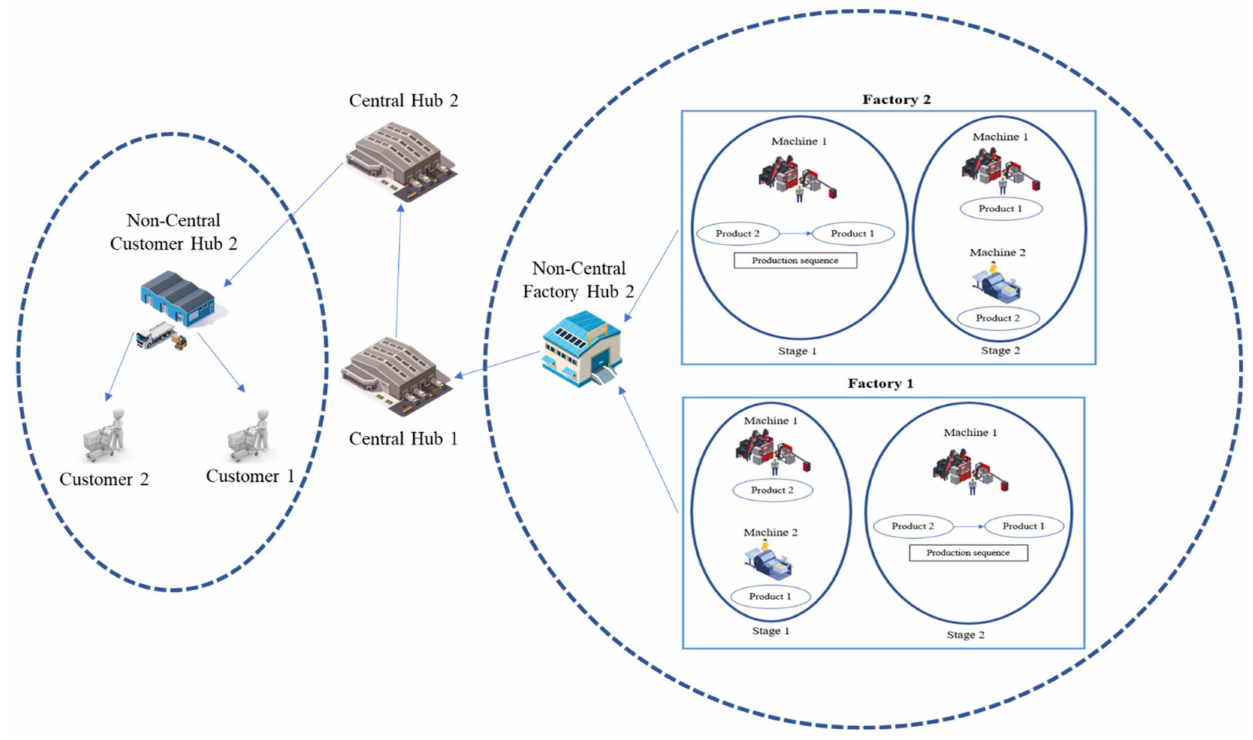
Figure 4. The network of the small